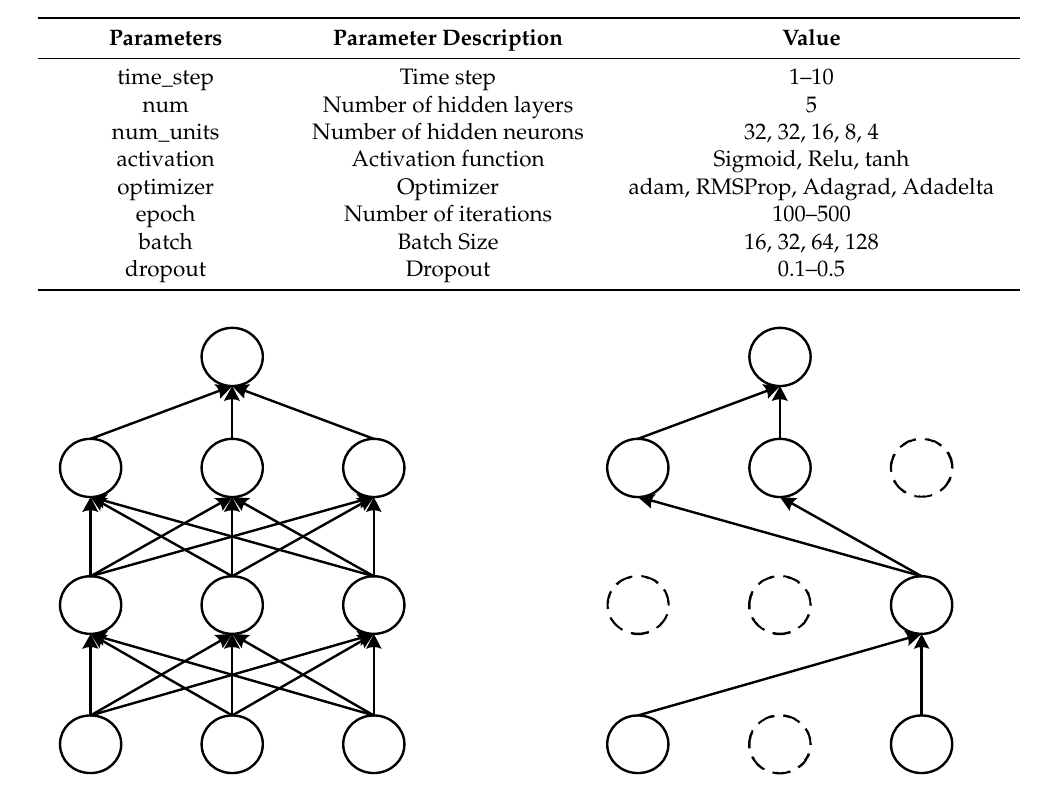
Table 1. The Model hyperparameter setting.